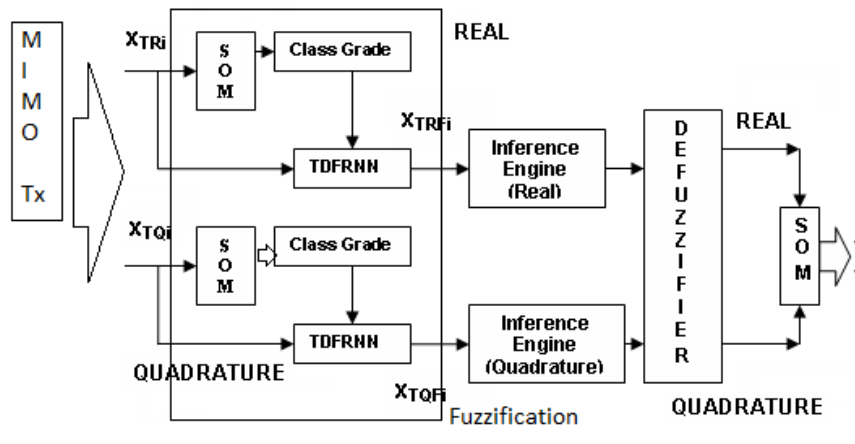
Figure 2. Fuzzy system based channel